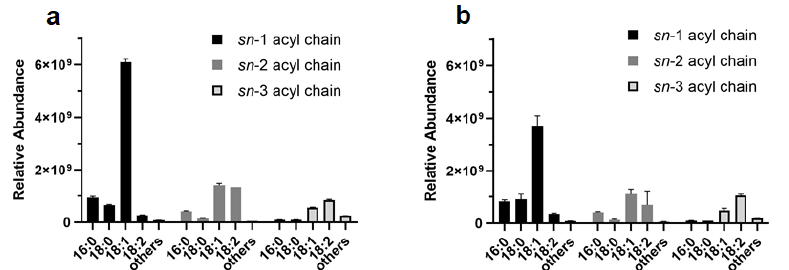
Figure 8. Relative abundance of acyl chains in DGs and TGs extracted with ET ( a ) and MTBE-ME ( b ).